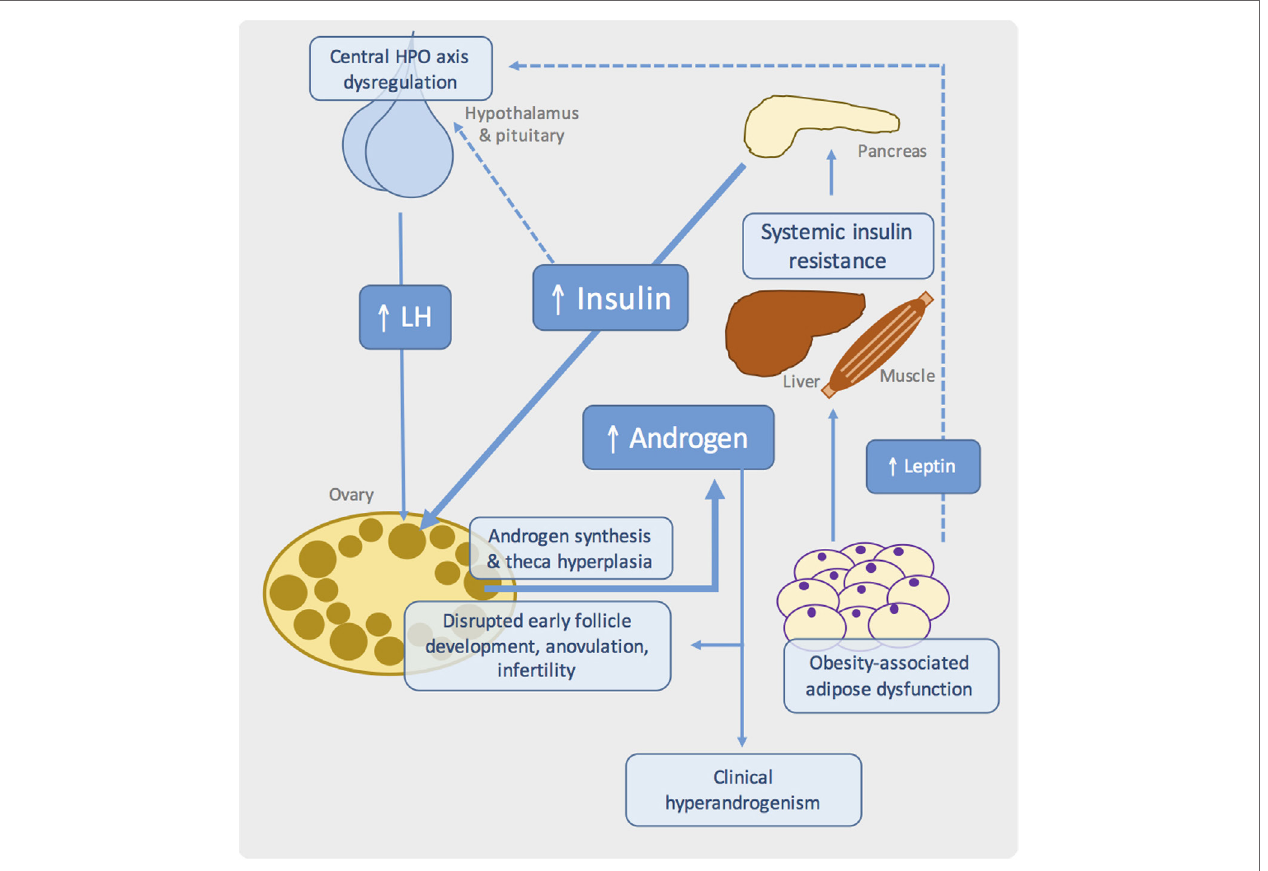
FiGURe 1 | Proposed pathogenic mechanisms in obesity-associated ovarian dysfunction and subfertility . Schematic showing the major metabolic and reproductive pathways involved in PCOS. Systemic insulin resistance, commonly due to adipose tissue dysfunction in the context of obesity, results in compensatory hyperinsulinemia. At the ovary, insulin synergizes with luteinizing hormone (LH) to drive androgen synthesis. Disrupted insulin, growth factor, gonadotrophin, and sex steroid signaling in the ovary leads to failure of follicle development and ovulation. Genetic and developmental influences are also likely to play an important